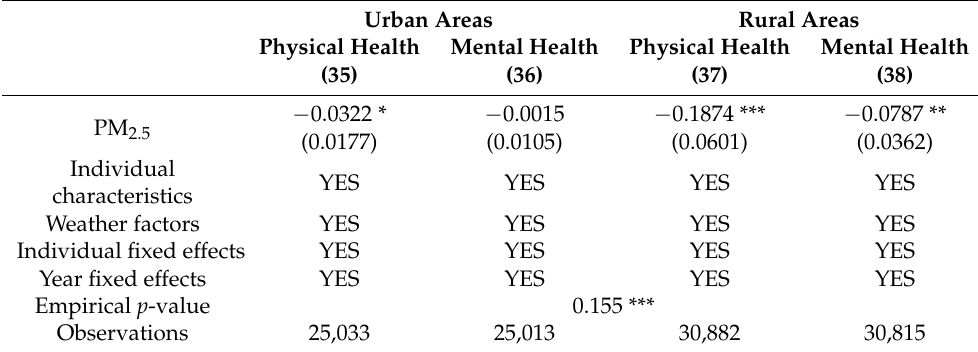
Table 11. Heterogeneity effects with household